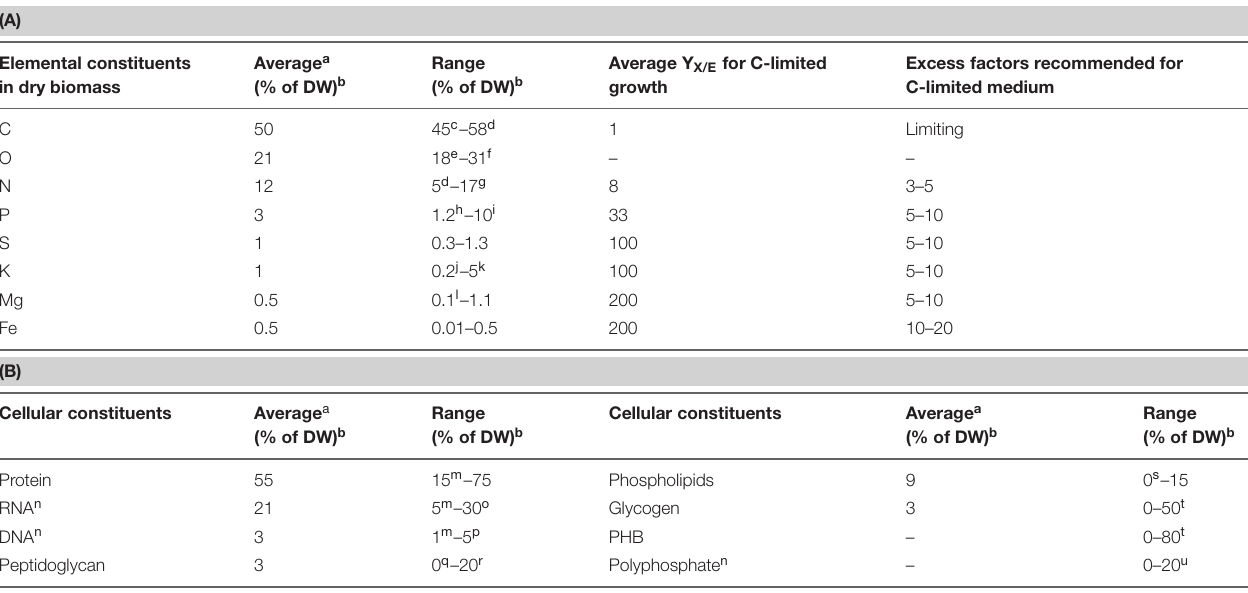
TABLE 1 | Average elemental composition (A) and content of major cellular polymeric constituents of microbial biomass (B), and range of variation with the corresponding environmental conditions (condensed from Egli,